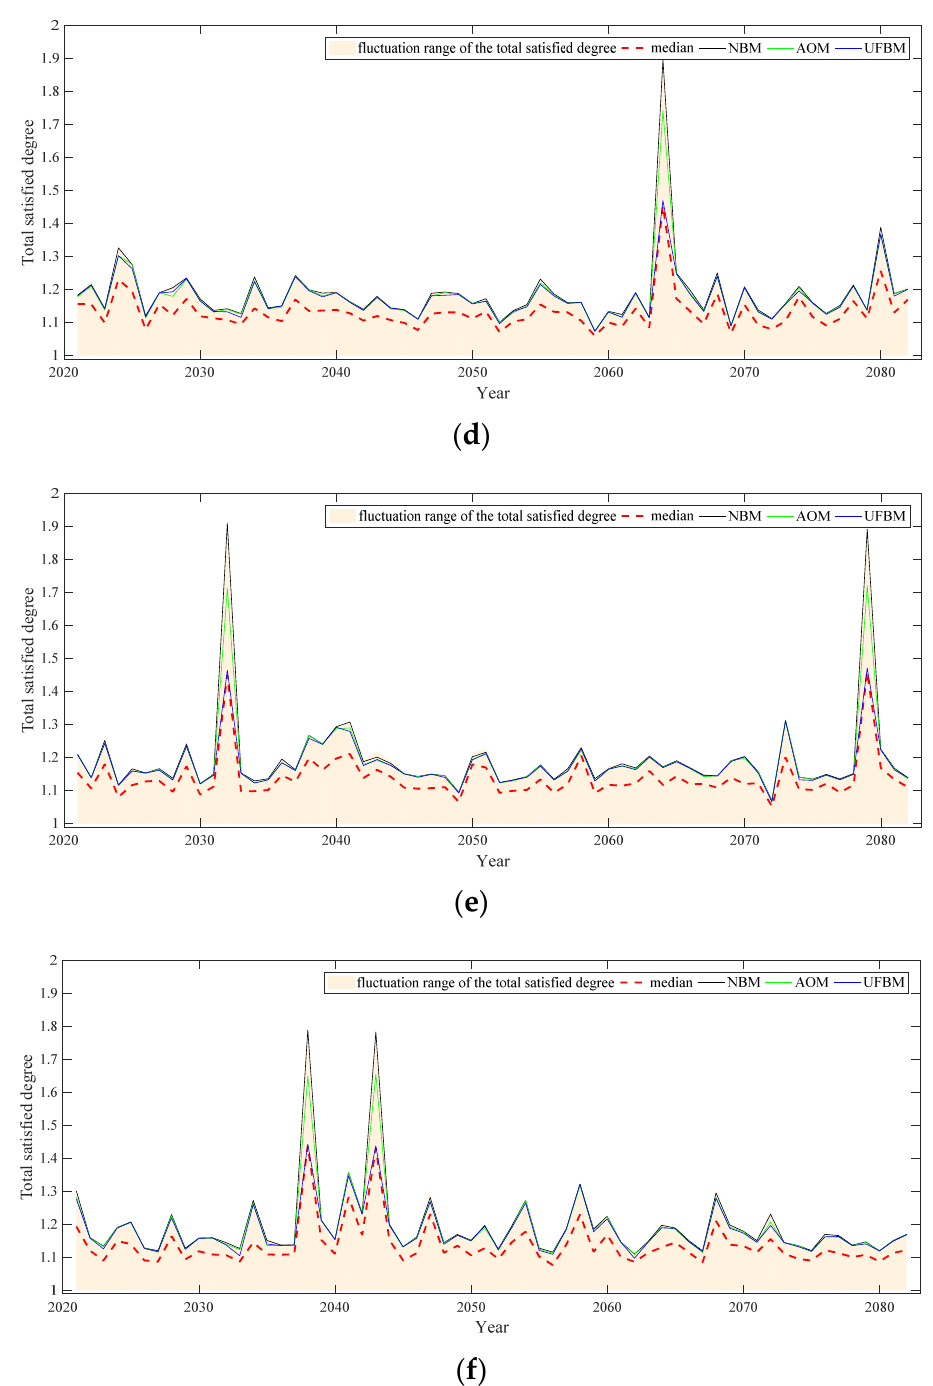
Figure 10. Satisfaction levels for the balanced strategies selected by NBM, AOM, and UFBM for each water-conflict year based on different GCMs under AEF pattern: ( a ) GCM1; ( b ) GCM5; ( c ) GCM10; ( d ) GCM15; ( e ) GCM20; ( f ) GCM25 (NBM: Nash bargaining method; AOM: alternating offer method; UFBM: unanimity fallback bargaining method; AEF: appropriate environmental flow).